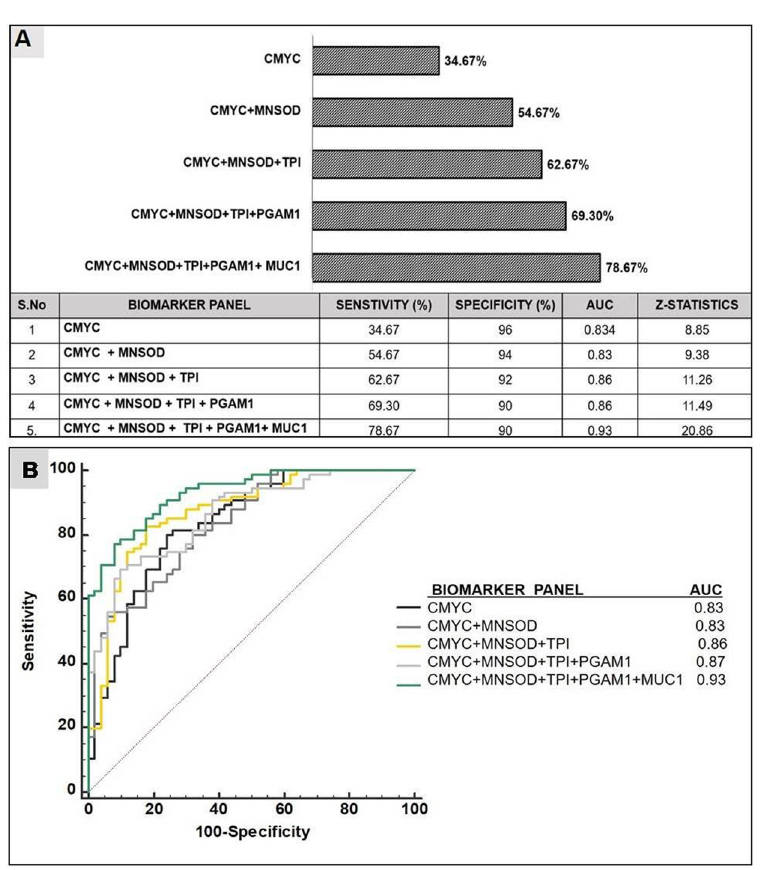
Figure 9. Diagnostic value of different autoantibody biomarker panels for canine mammary tumour: ( A ) With successive addition of TAAs to a total of 5 antigens in the multiplex assay, there is a stepwise increase in sensitivity. Out of 75 CMT sera samples analysed, 78.67% showed detectable level of autoantibodies cumulatively to any of these five TAAs, which was significantly higher than the frequency in sera from healthy individuals(n = 50) (p < 0.001). ( B ) Comparison of ROC curves reveals that with increase in the number of biomarkers in the panel, there is also an increase in AUC, with maximum AUC of 0.931(p < 0.0001) for the combined panel of five biomarkers.